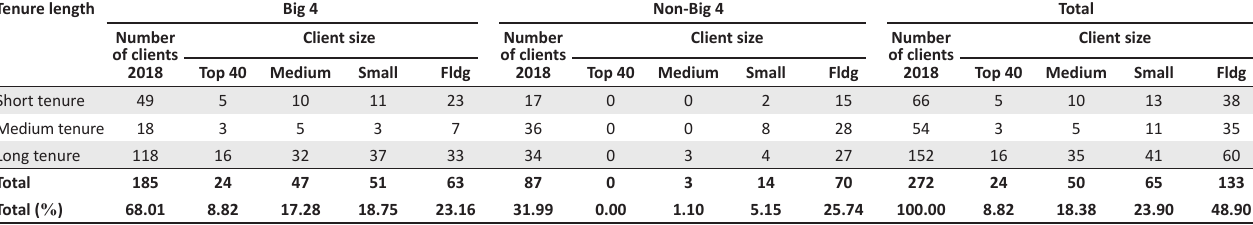
TABLE 7 : Number of clients per audit firm tenure length, audit firm size and client size